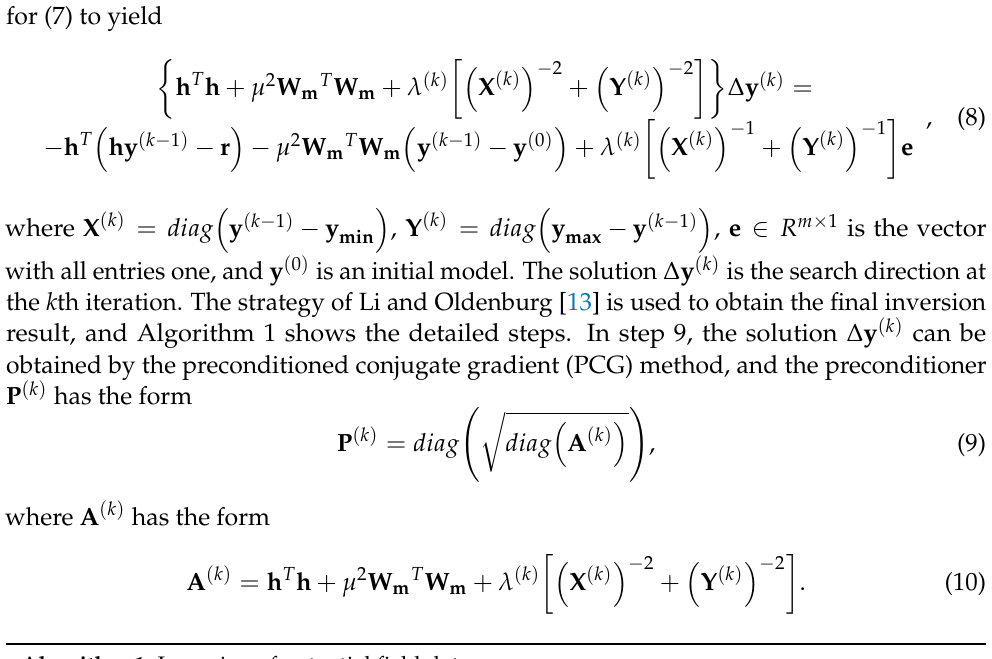
Algorithm 1. Inversion of potential field